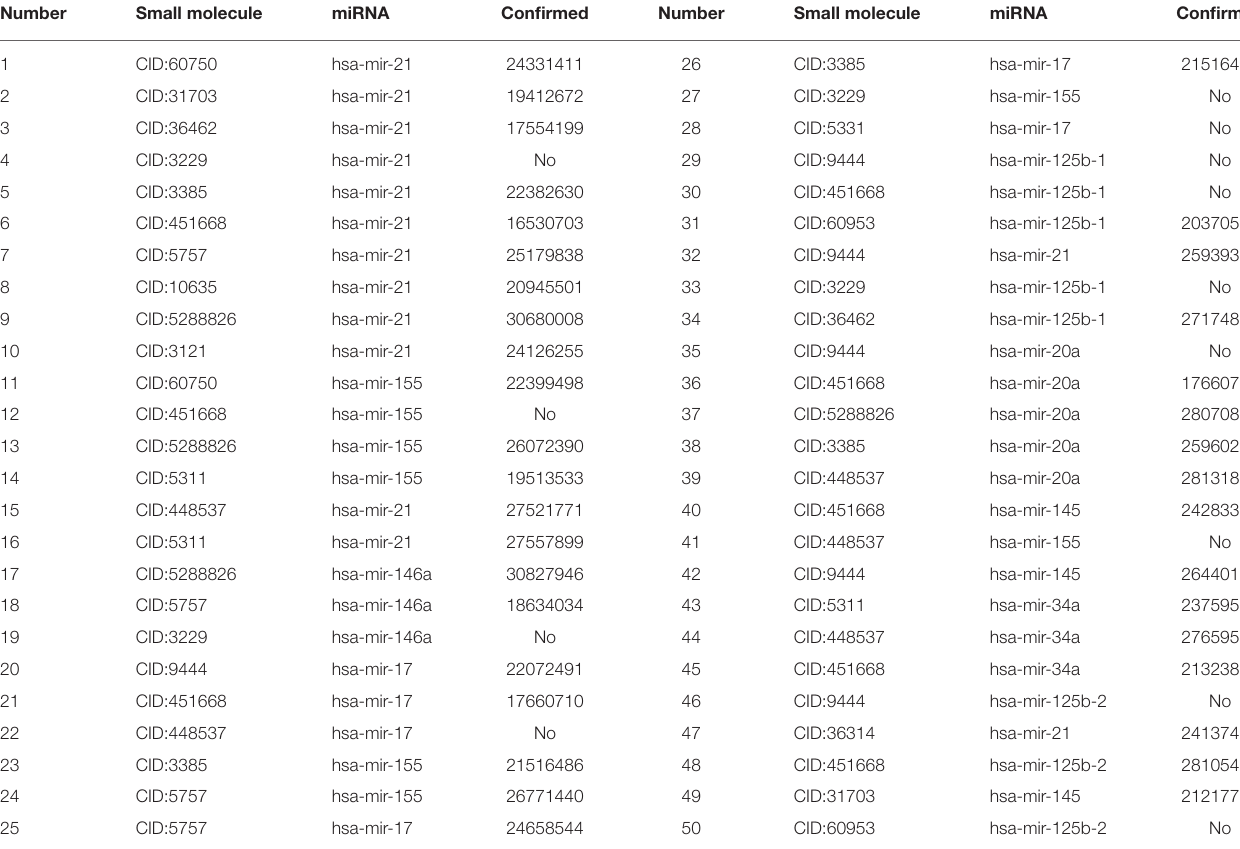
TABLE 6 | The predicted top 50 SMiR associations with the highest scores. Number Small